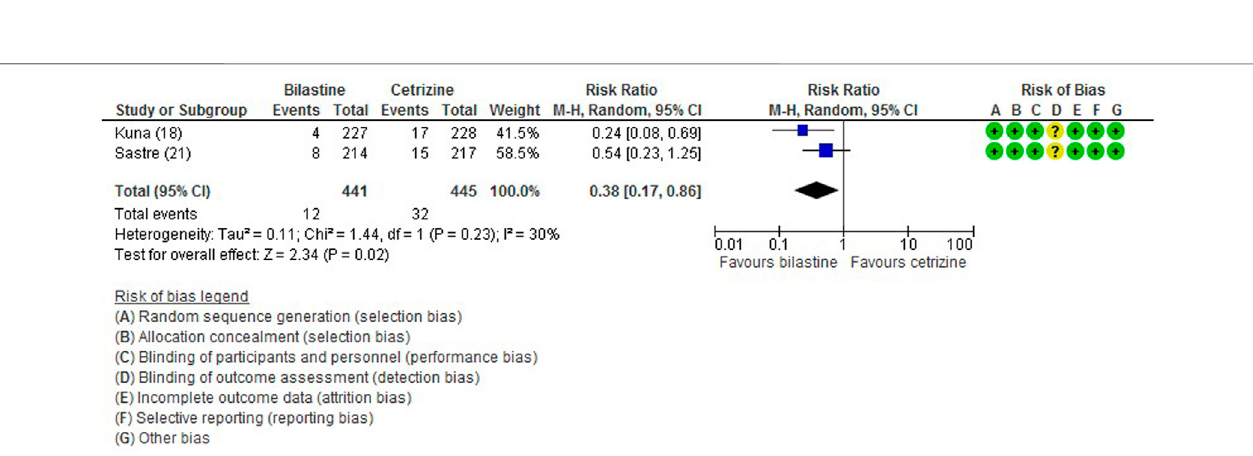
FIGURE 11 | Comparison between bilastine and cetirizine for somnolence. CI Con fi dence interval, df degrees of freedom.